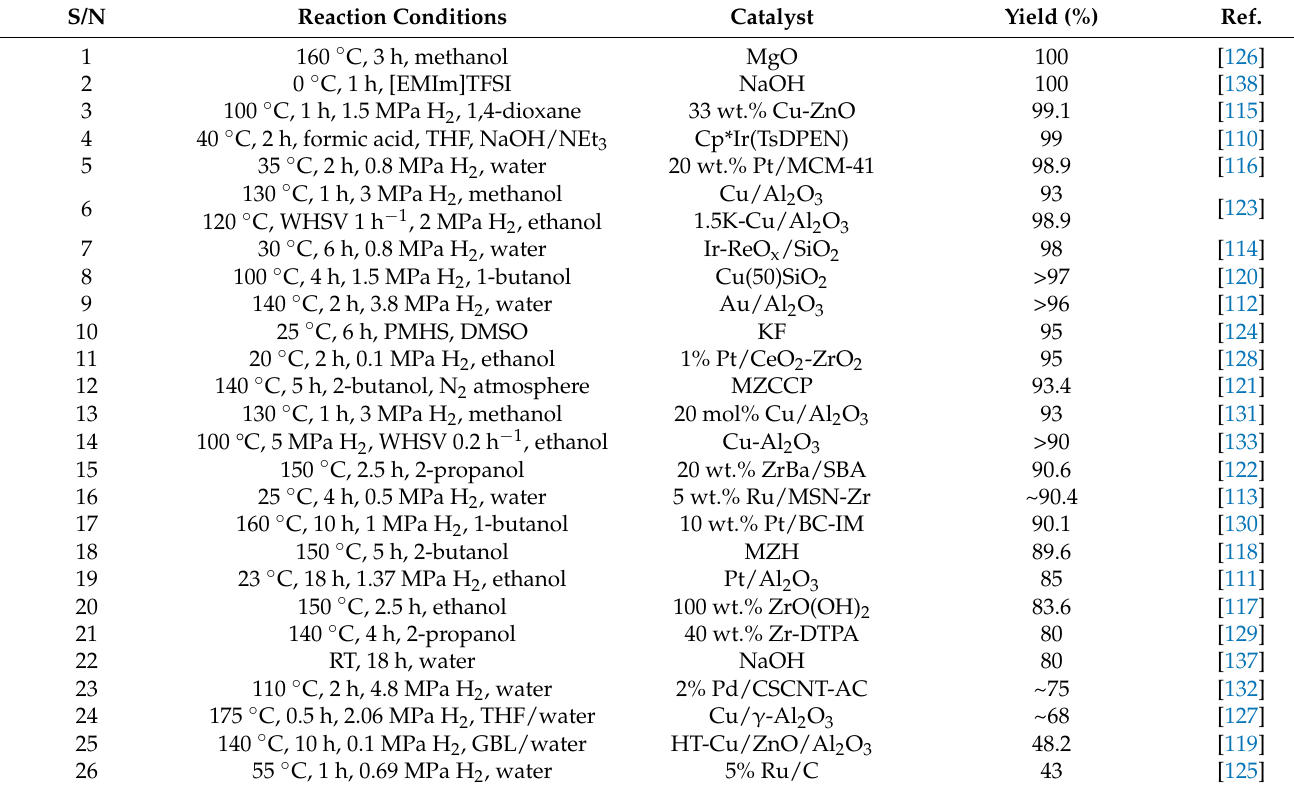
Table 3. Selective preparation of BHMF from